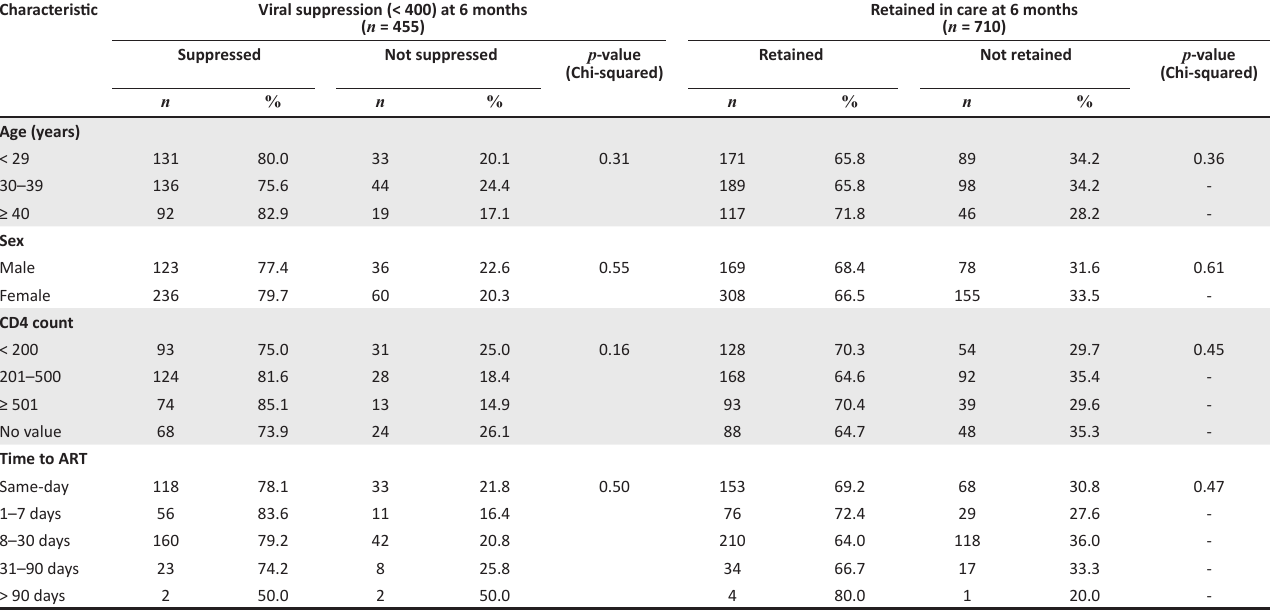
TABLE 3: Viral suppression and retention in care at 6 months for those who are on antiretroviral therapy. Characteristic